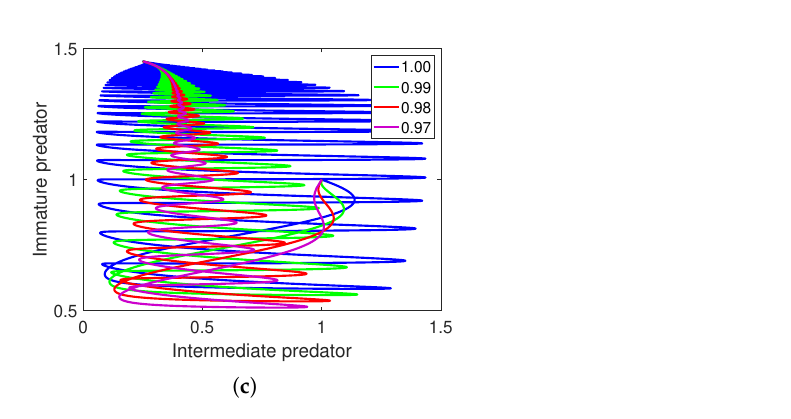
Figure 3. The 2D dynamics of different phase planes of model (2) with different fractional orders.